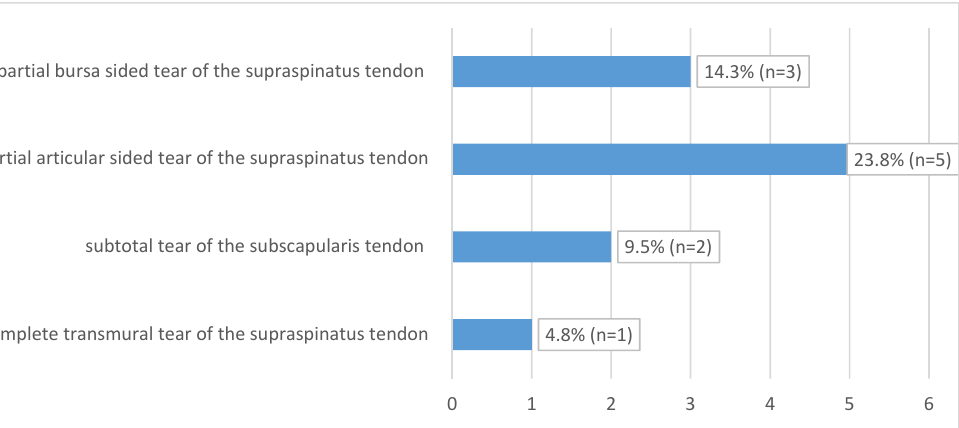
Figure 4. Concomitant intra-articular injuries detected through preoperative magnetic resonance imaging (MRI) and of a ff ected